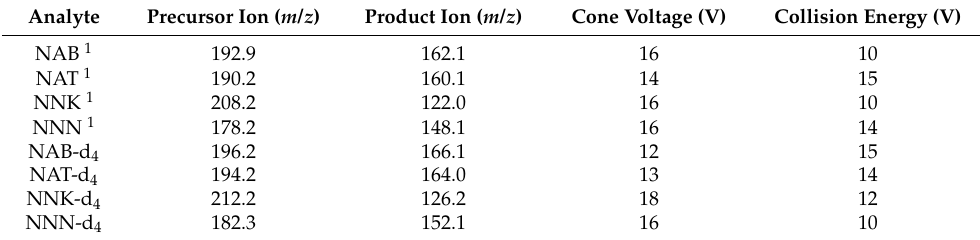
Table 1. MS/MS instrument parameters for the detection of TSNAs.